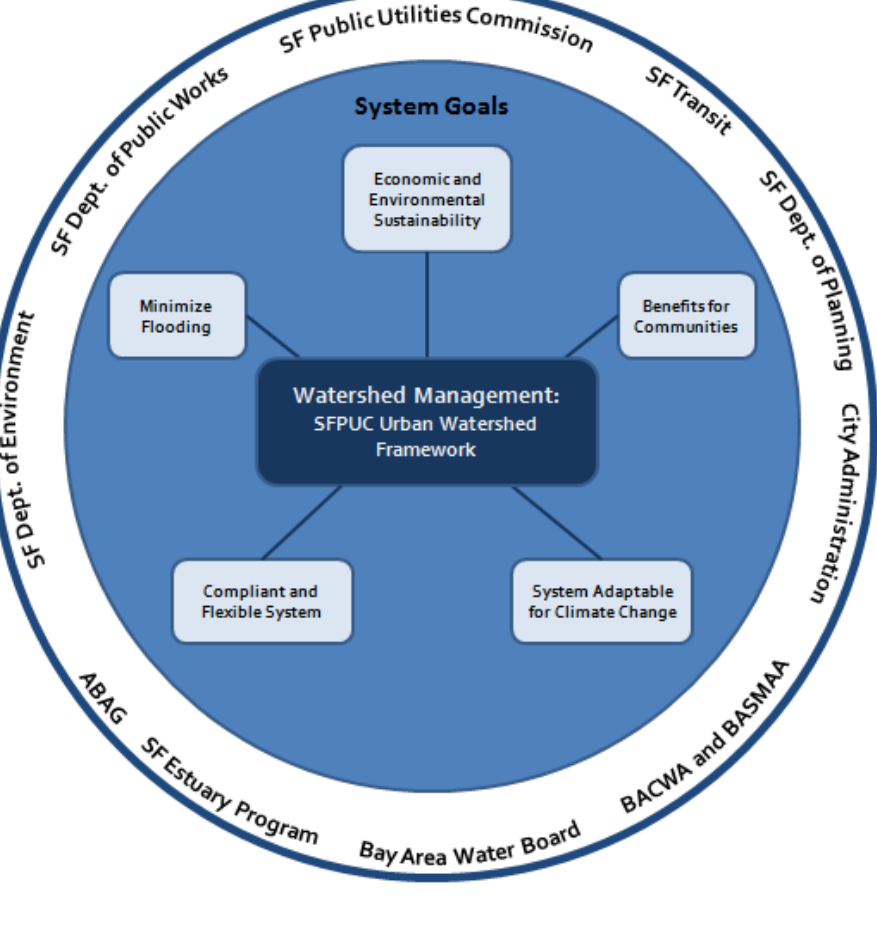
Figure 3. Integrated framework for San Francisco stormwater